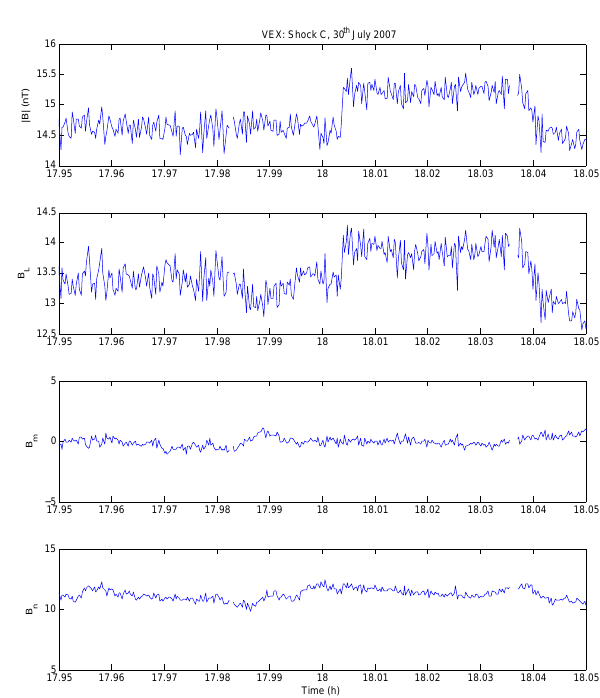
Fig. 7. Shock D: observed by VEX at 18.91UTC on 30 July 2007. | B | , B L , B m and B n are the magnetic field magnitude, the compo- nent in the shock plane parallel to the projection of the upstream magnetic field, the component in the plane of the shock perpendic- ular to the projection of the upstream field and the field component along the normal direction respectively.